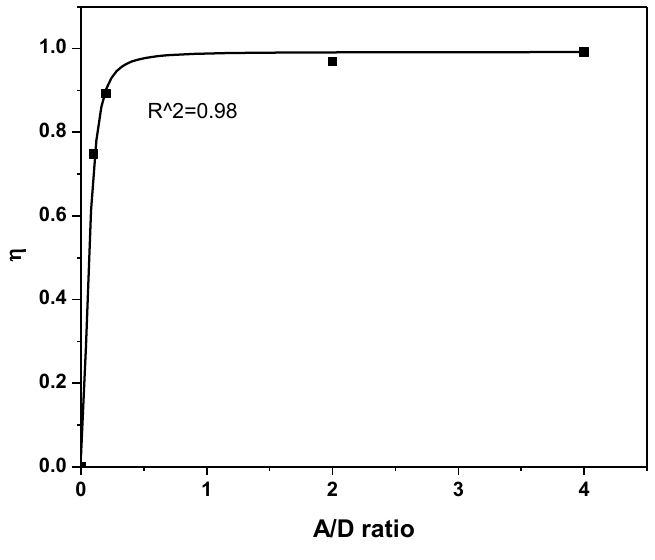
Figure 8. Energy transfer efficiency for 0-D Cs 4 PbBr 6 /MEH-PPV hybrid thin films. Table 2. Energy Transfer Parameters of the Donor / Acceptor Thin